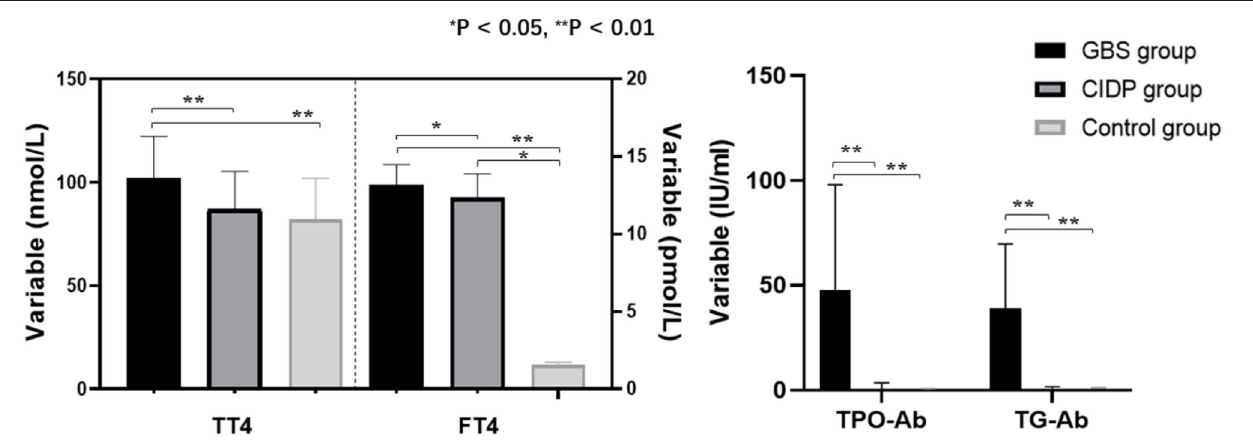
FIGURE 1 | Comparison of thyroid function and autoantibodies parameters among the GBS, CIDP, and Control groups. TT4, FT4, TPO-Ab, and TG-Ab levels were all higher in the GBS group than in the CIDP and Control groups (** P < 0.01, * P < 0.05).